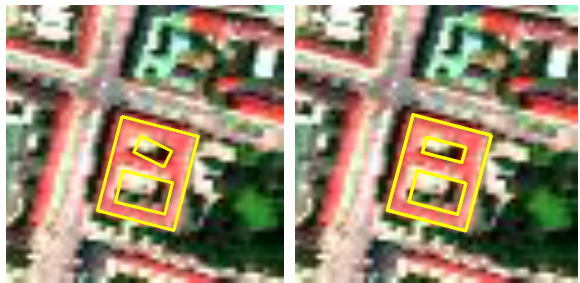
Figure 4: Result of building boundary approximation with sub- pixel accuracy (yellow lines). Outer and inner building boundaries are: independently adjusted (left), and adjusted with the condition that they have the same orientation (right).